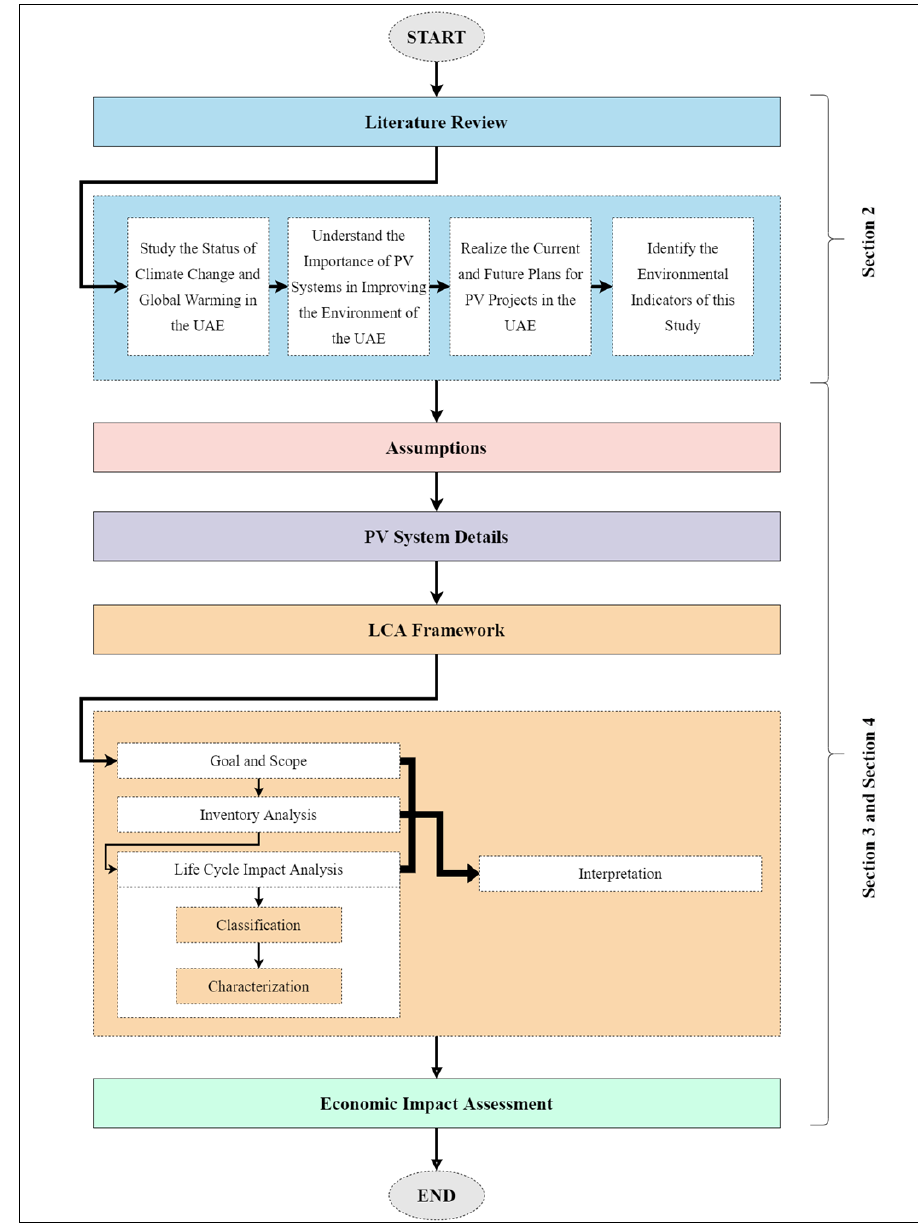
Figure 2. Methodology framework.